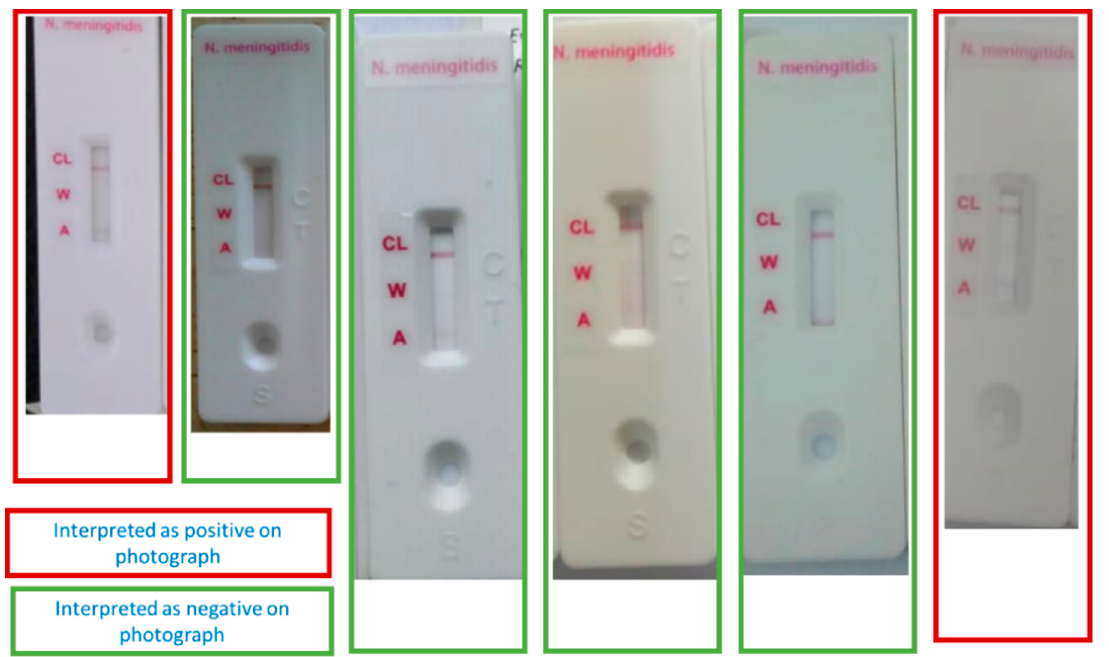
Figure 1. Photographs of six false positive NmA RDTs by independent expert classification, Burkina Faso and Niger, 2018–2019.